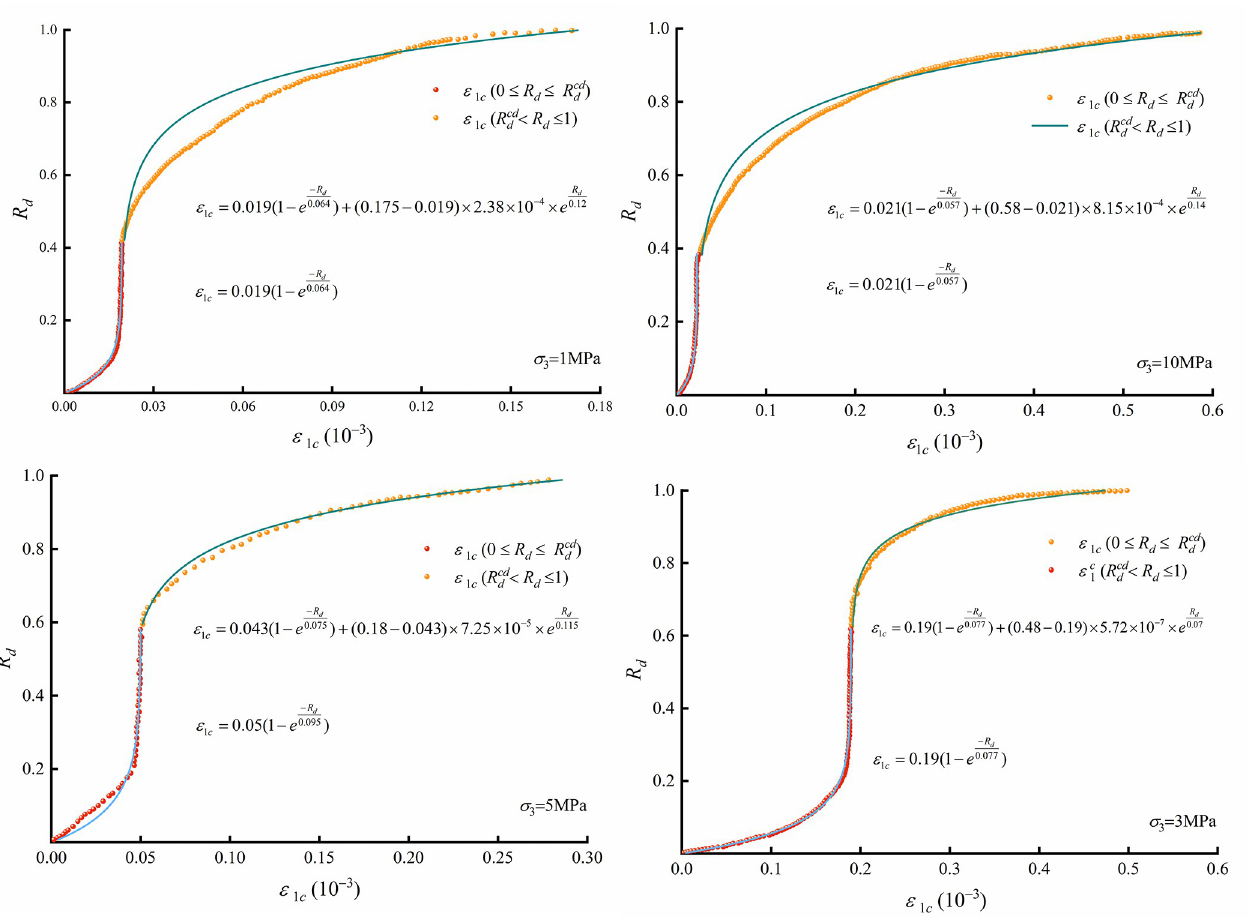
Fig 12. Axial crack strain results and model fitting from triaxial compression tests of micritic bioclastic limestone.